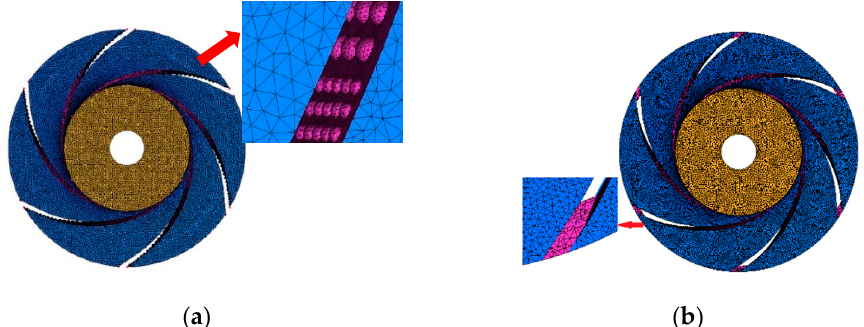
Figure 5. Grid of bionic impeller. ( a ) Bionic pit impeller; ( b ) bionic sawtooth impeller.